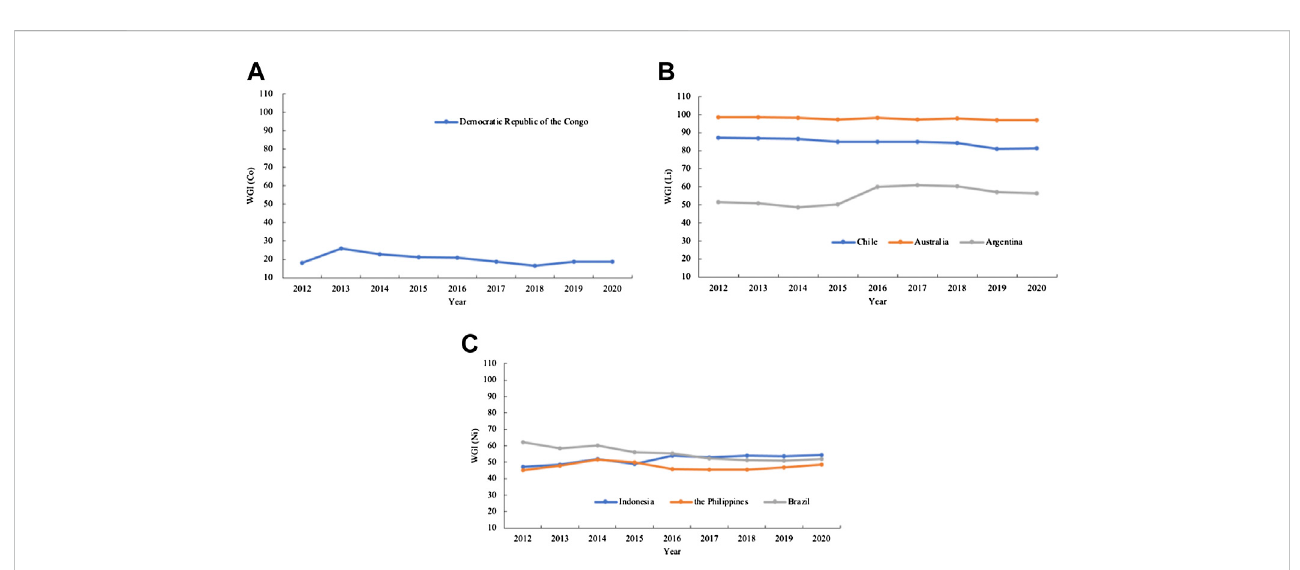
FIGURE 1 Change trend of cobalt (A) , lithium (B) , and nickel (C) resource supply risk index based on WGI.